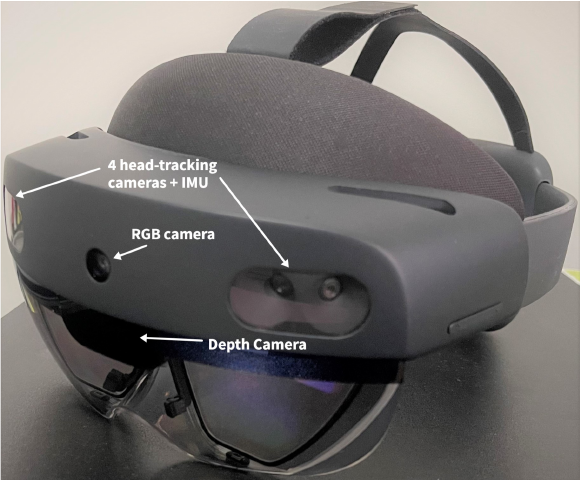
Figure 6. Microsoft HoloLens Gen